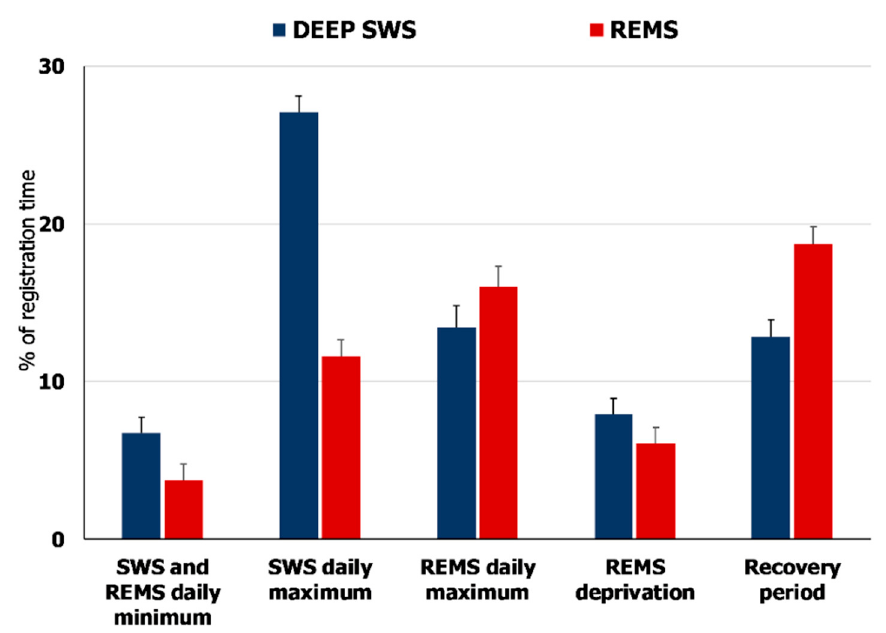
Figure 8. Total time of deep slow-wave sleep (DEEP SWS) and REM sleep (REMS) over the natural daily sleep–wake cycle (daily minimum and maximum of both states), during 6 h selective REM sleep deprivation (REMS deprivation) and the recovery period after the deprivation. Values are shown as mean ± s.e.m.